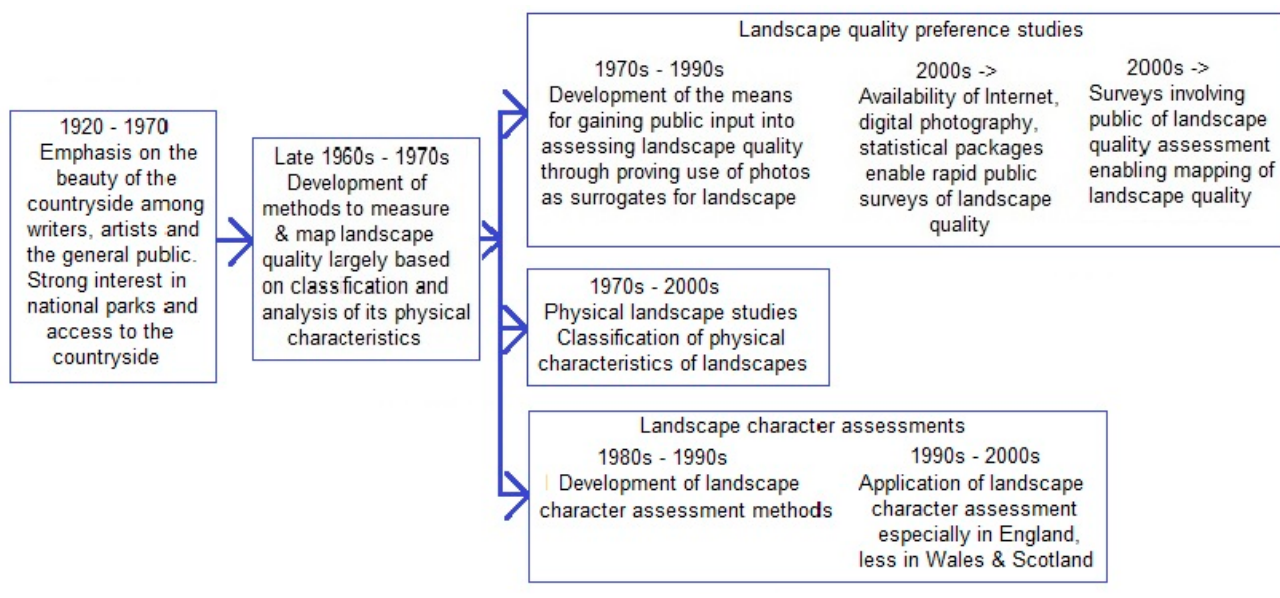
Figure 7. Evolution of landscape assessment methods – Great Britain.